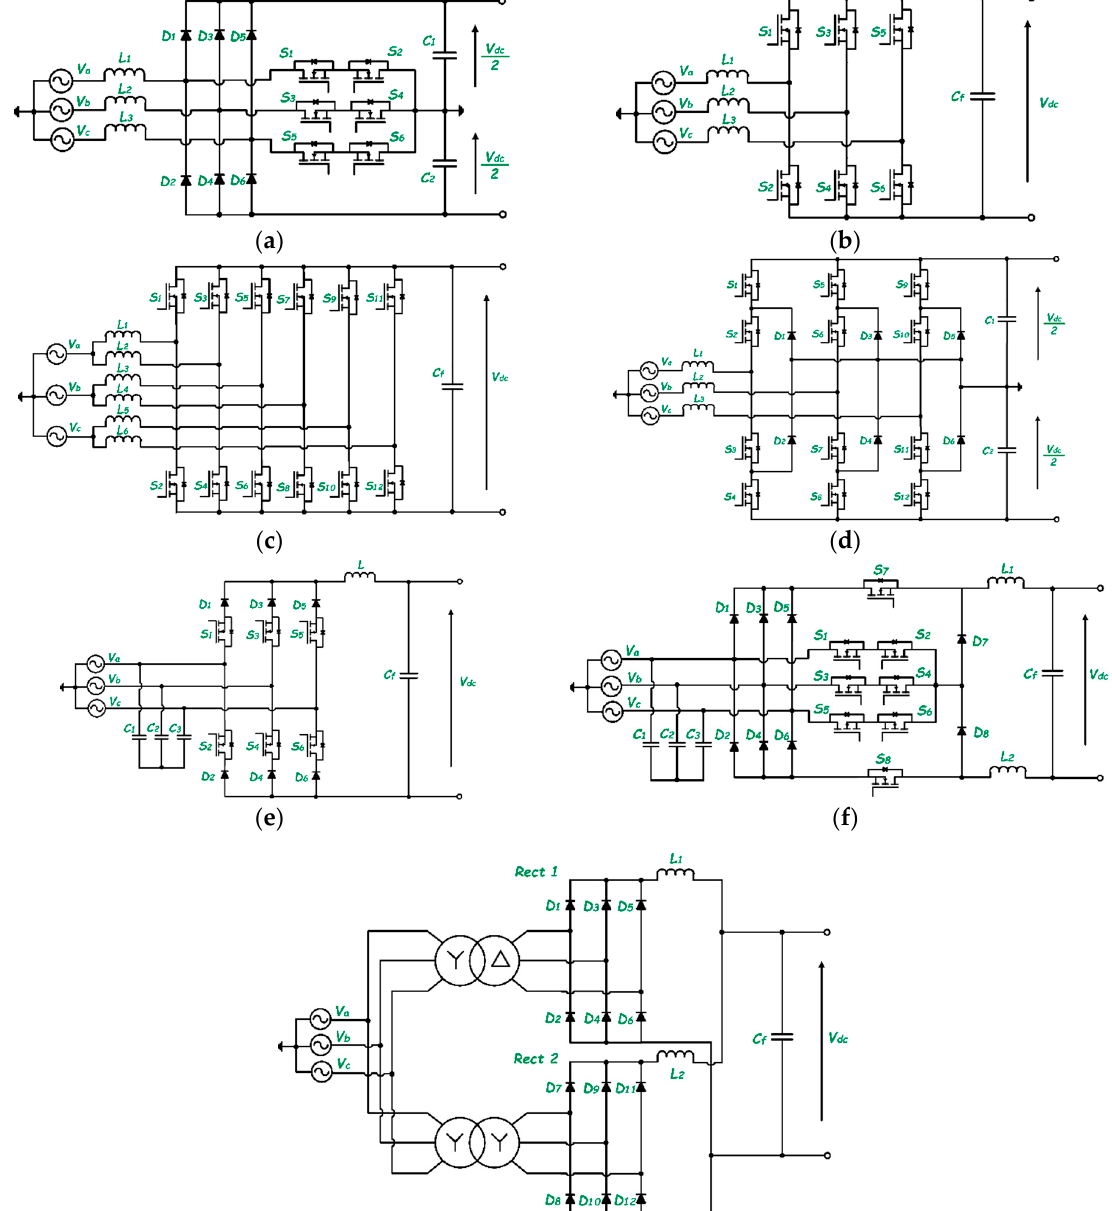
Figure 6. Front-end rectifier topologies: ( a ) Vienna boost rectifier; ( b ) voltage source six-switch boost rectifier; ( c ) bidirectional interleaved converter; ( d ) NPC converter; ( e ) current source six-switch buck type PFC rectifier; ( f ) Swiss buck rectifier; ( g ) 12-pulse diode rectifier.